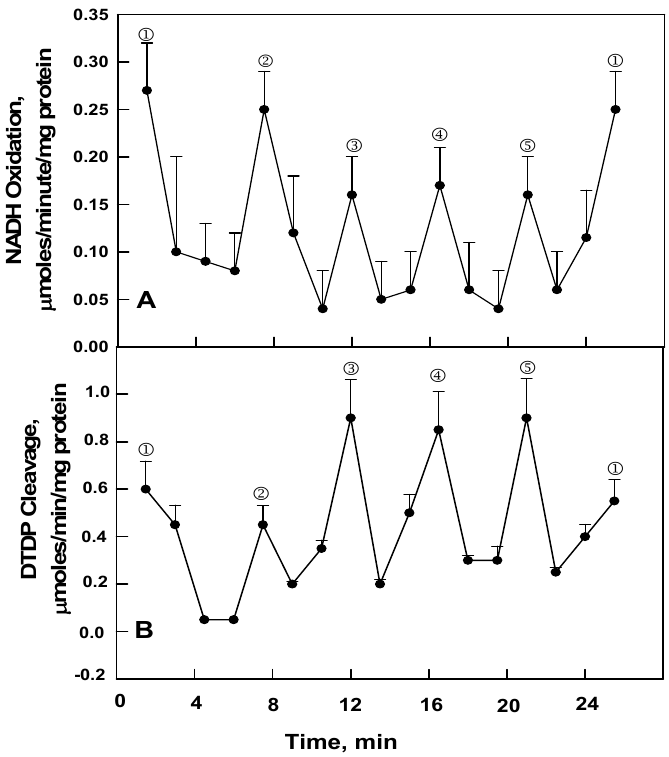
Figure 2. Averages of 3 (B) or 4 (A) decomposition fits [11] ± standard deviations of oscillatory patterns of human ENOX1 activity with a period length of 24 min. ( A ) NADH oxidation measured as the decrease in A 340 averaged over 1 min every 1.5 min; ( B ) Protein disulfide-thiol interchange activity measured from the cleavage of the artificial substrate dithiodipyridine (DTDP). Note that the two activities tend to alternate with maxima ① and ② separated by 6 min enhanced for NADH oxidation whereas maxima ③ , ④ and ⑤ separated from each other and maxima ① and ② by 4.5 min are more conspicuous for DTDP